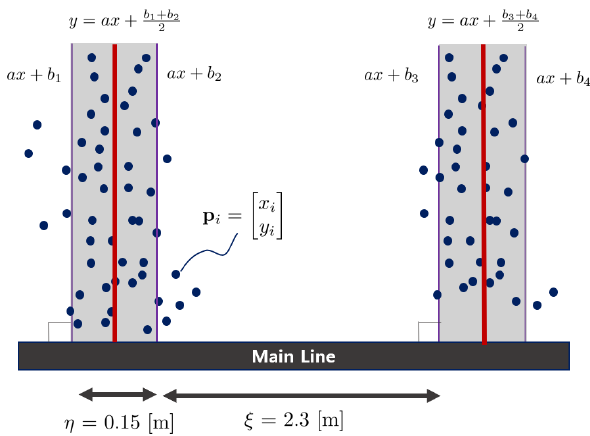
Figure 9. The process of identifying the support line. The support line can be estimated by optimizing the least squares method. The red line indicates the center of the support